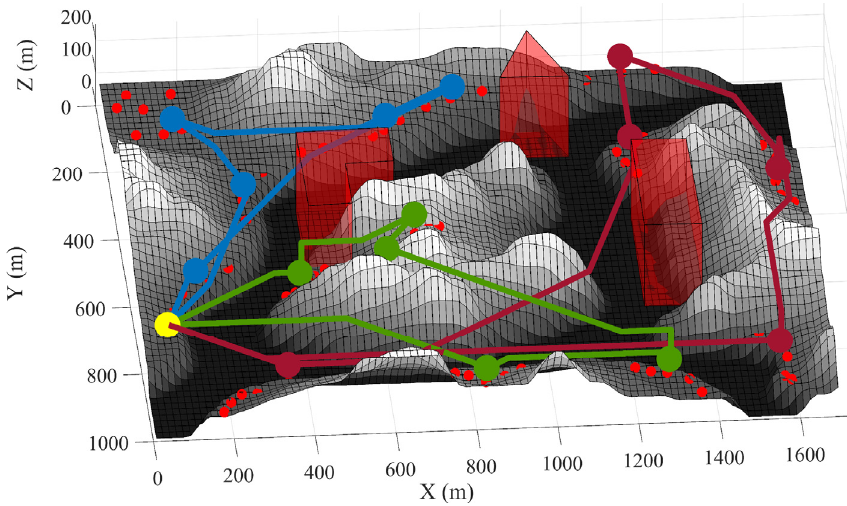
Figure 10. Same paths as in Figure 9, but shown in 3D.